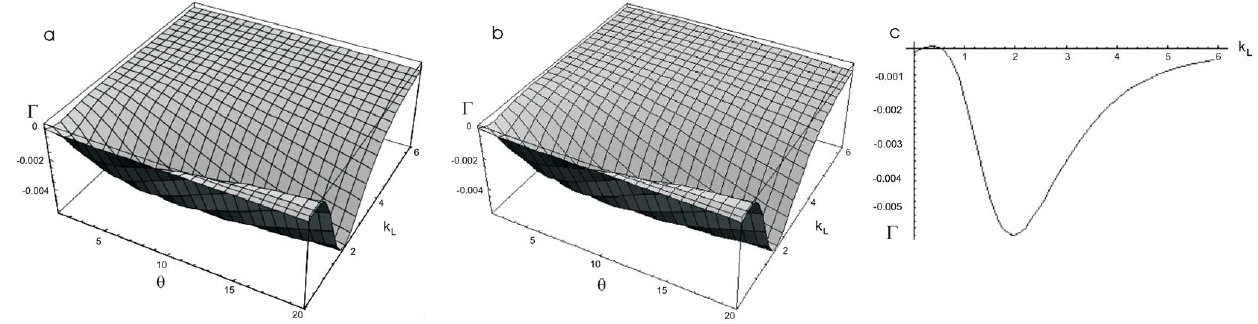
Fig. 1. (a) The reduced growth rate of the ion-acoustic instability in plasma with Coulomb conductivity for the FAL P3 model at (ε R ) bound = 0 . 04, σ = 1, 2 bound = 17, (k L ) bound = 0 . 11 and 0 1 ( + ) = 1 . 33 × 10 − 6 ; (b) the reduced growth rate of the ion-acoustic instability for the FAL P2 model at (ε R ) bound = 0 . 09, 2 bound = 17, (k L ) bound = 0 . 21 and 0 1 ( + ) = 9 . 28 × 10 − 6 ; (c) cross section of the surface 0 = 0(2,k L ) by the plane 2 = 17 for the FAL P2 model (see panel b ). Table 3. Limit values of the ion-acoustic instability in the pre-flare plasma with Coulomb conductivity. Models of the solar atmosphere (ε R ) bound σ (2) bound FAL